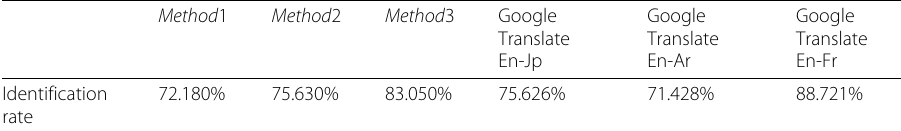
Table 3 Evaluation of the methods and comparison with Google Translate on the same set of